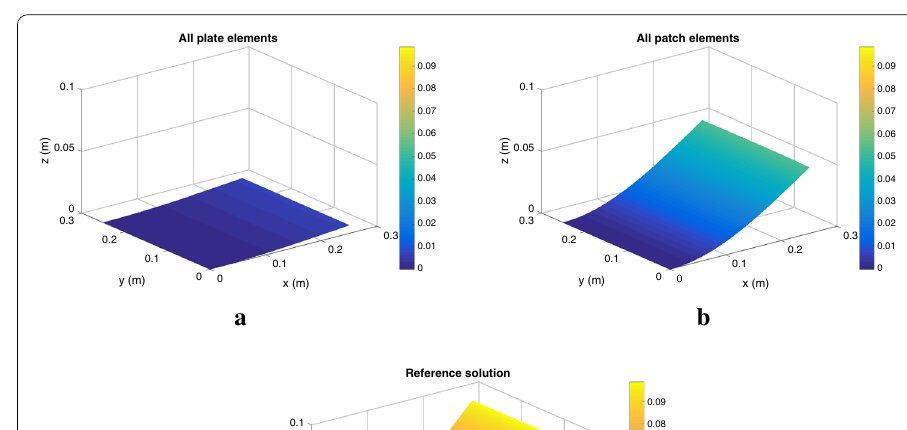
In the elastic case the problem weak form associated with the strong form (43) results in looking for the displacement field u verifying the initial and Dirichlet boundary conditions, and fulfilling